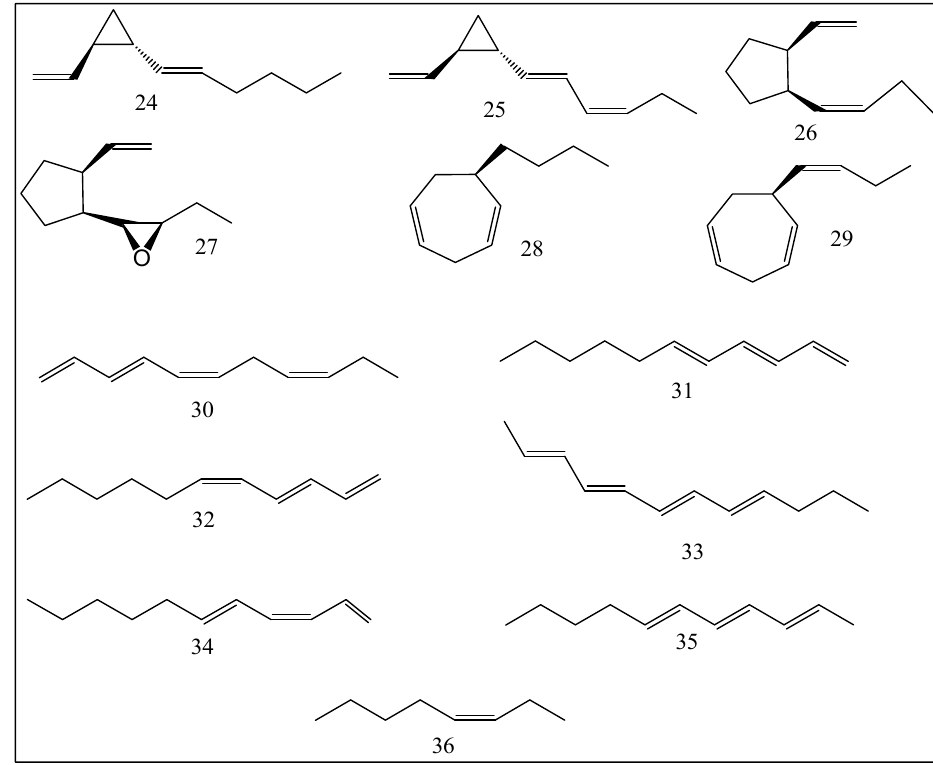
Figure 9. Odoriferous C11 hydrocarbons from Dictyopteris species.